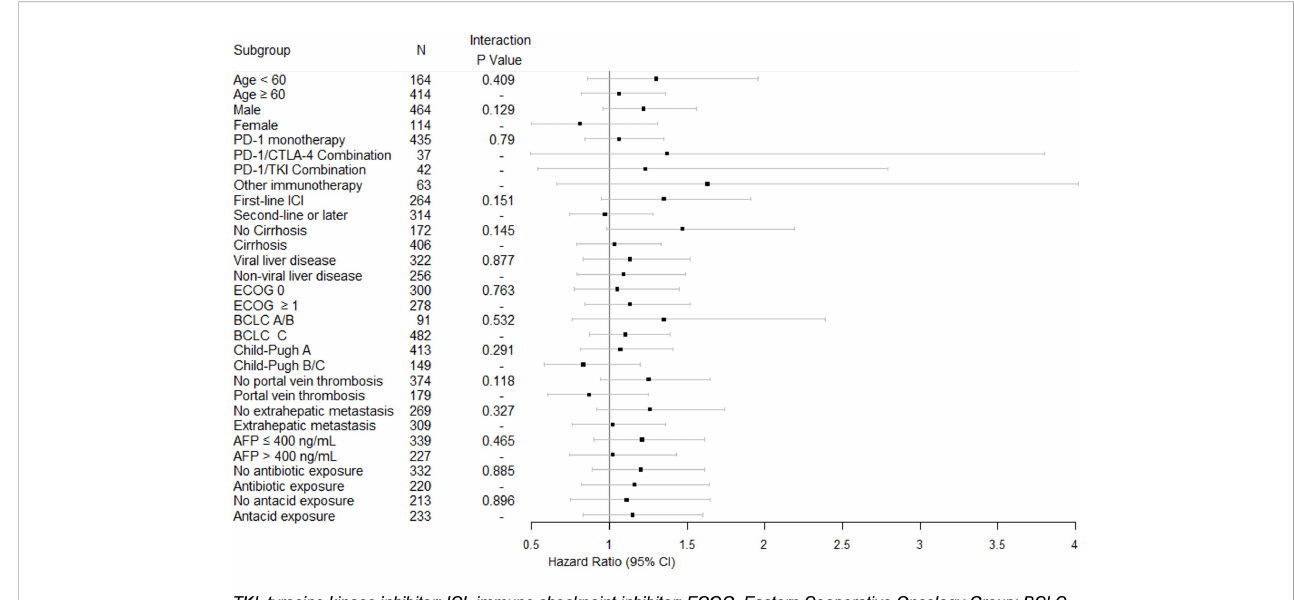
FIGURE 2 Univariable Cox proportional hazard model of overall survival with interactions between beta blocker exposure and subgroups. Hazard ratios and 95% con fi dence intervals for beta blocker exposure are shown with P values for each